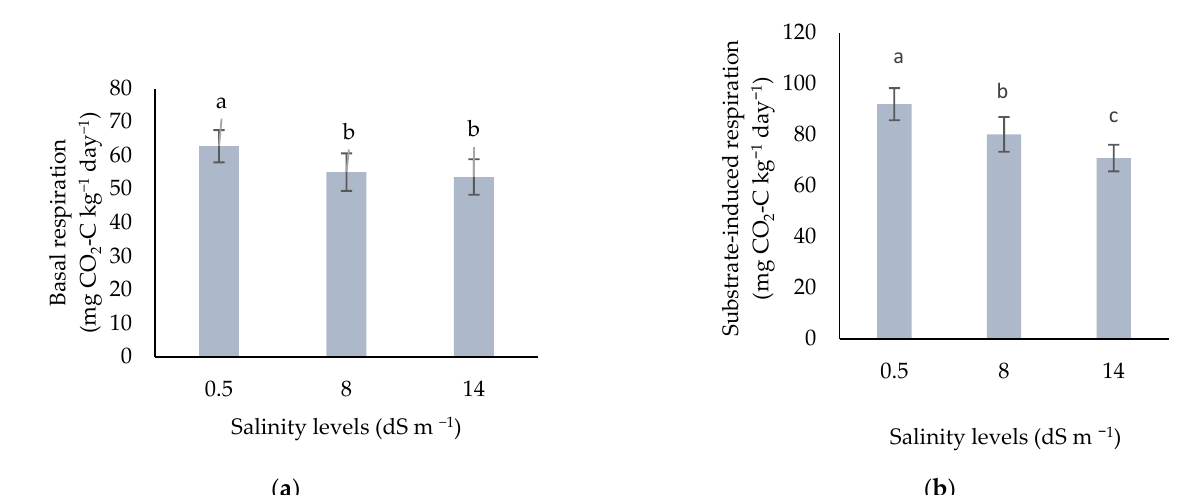
Figure 2. The effect of salinity on ( a ) basal respiration and ( b ) substrate-induced respiration. Bars show means ± standard error of the mean. Means with a different letters indicate significantly different values at p < 0.05 based on Duncan’s multiple range test.